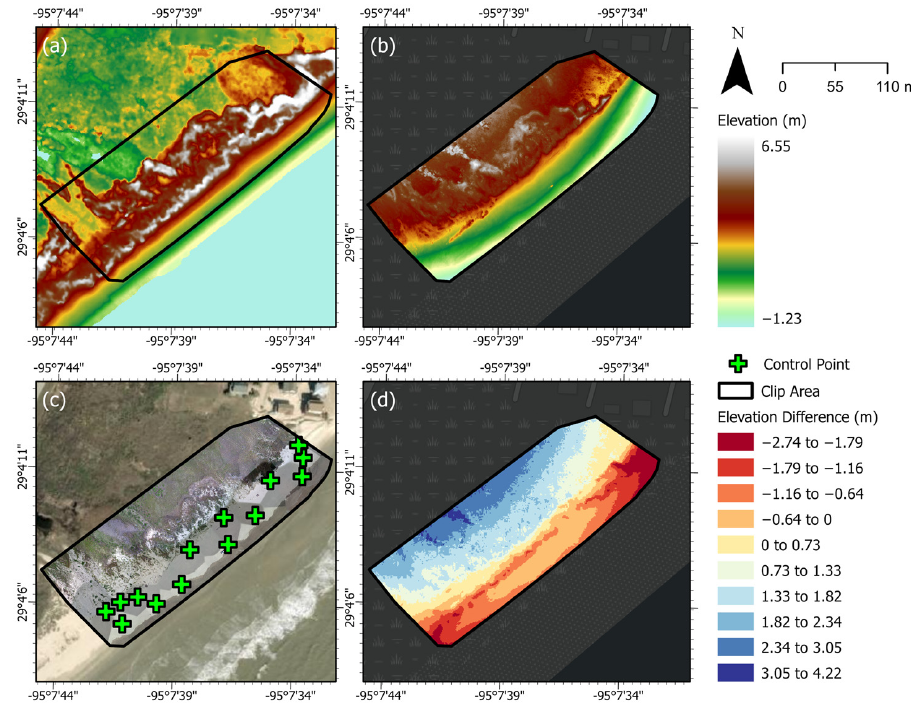
Figure 16. Follett’s Site 2 comparison of 2022 UAV data and 2018/2019 data. Spatial Reference: NAD 1983 UTM Zone 15n. ( a ) 2018/2019 NOAA’s Post Hurricane Harvey elevation model with survey clipping boundary; ( b ) May 2022 digital elevation model; ( c ) May 2022 orthophoto with a World Imagery Maxar base map; ( d ) Elevation difference map with erosion represented as orange through red, and deposition represented by yellow to blue.